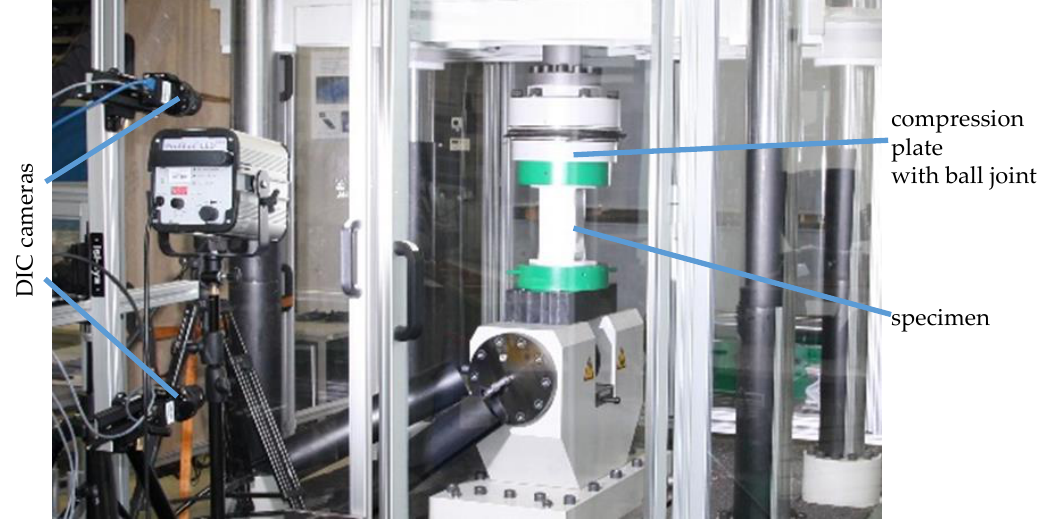
Figure 14. Test setup for the axial compression test with DIC cameras in place.